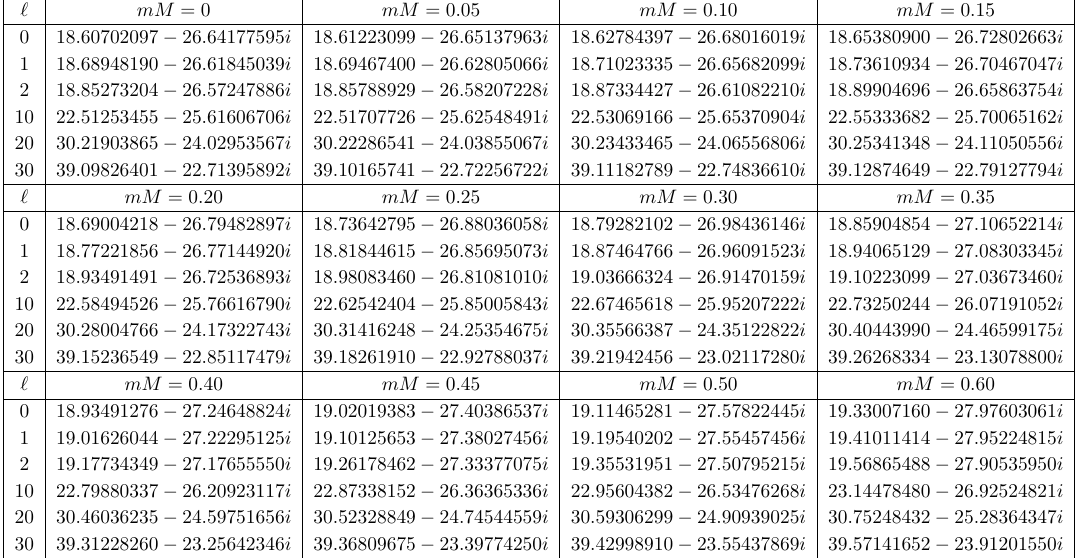
Table 7 . Fundamental quasinormal frequencies !M ( n = 0) of massive scalar (cid:12)elds with ‘ = 0 ; 1, 2 ; 10 ; 20 ; 30 in the background of Schwarzschild-AdS black holes with M 2 (cid:3) = (cid:0) 765075, or r H =R = 10, where R is the AdS radius.